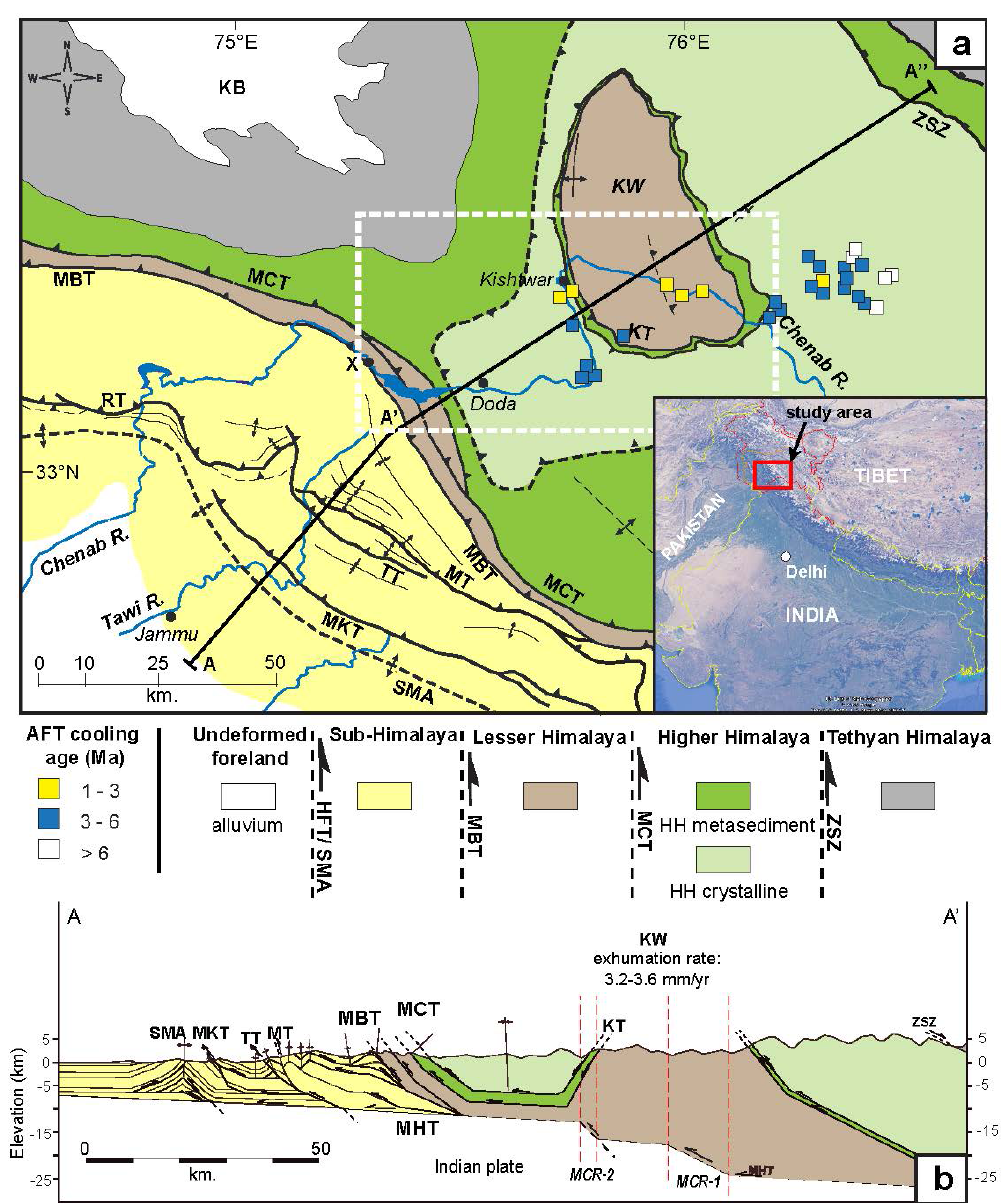
Figure 1. (a) An overview geological map of the western sector of the Indian Himalaya showing major lithology (simplified after Steck, 2003, and Gavillot et al., 2018) and existing structures (Vassalo et al., 2015; Gavillot et al., 2018). The tectonic Kishtwar Window (KW) is surrounded by exposure of the MCT, locally known as the Kishtwar Thrust (KT), and exposes the Lesser Himalayan nappes. The Lesser Himalaya forms a west-verging asymmetric anticline. Apatite fission-track (AFT) ages are adapted from Kumar et al. (1995). (b) A balanced cross section of the NW Himalaya showing the general architecture of the Himalayan orogenic wedge (simplified from Gavillot et al., 2018). Note that, beneath the KW, Gavillot et al. (2018) proposed the existence of at least two crustal ramps (MCR-1 and MCR-2) on the MHT, translation on which may have resulted in 3.2–3.6mmyr − 1 Quaternary exhumation rates across the